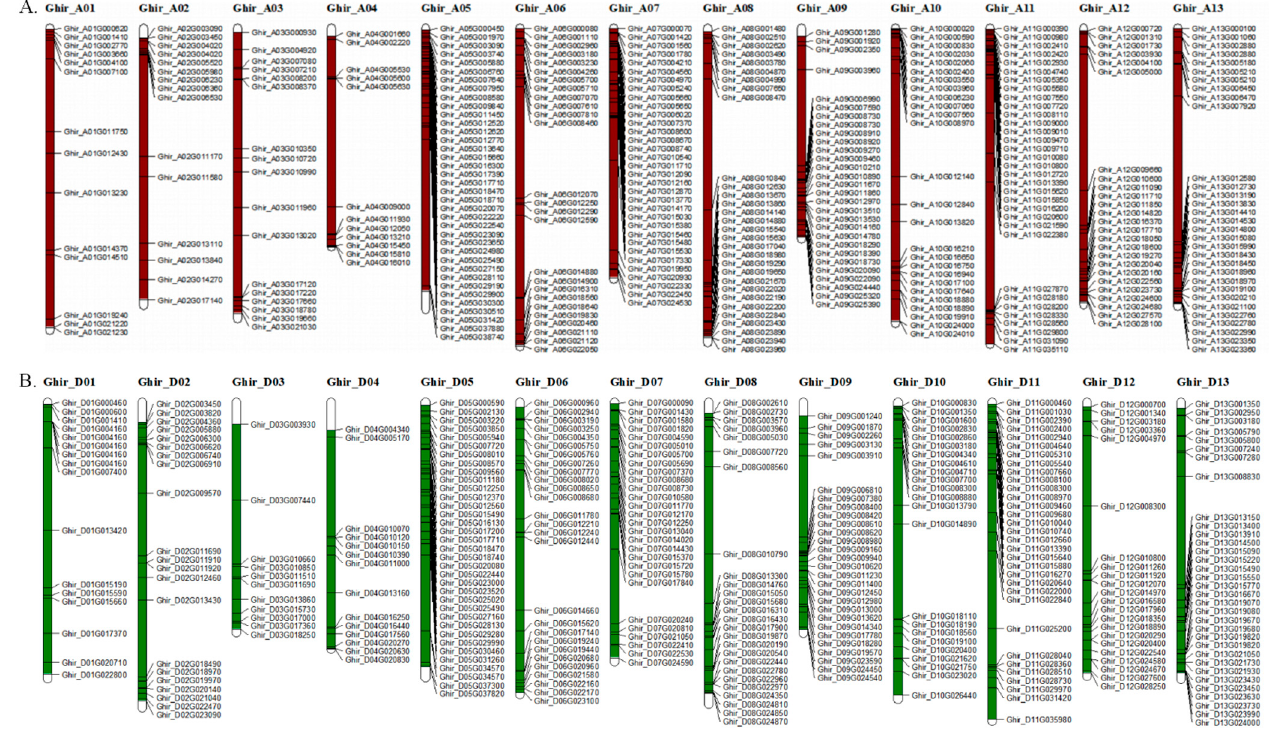
Figure 2. Distribution of flowering-related genes on G. hirsutum chromosomes. ( A ) Brownish bars: pseudochromosomes of the At subgenome; green bars: pseudochromosomes of the Dt subgenome. ( B ) Black lines on brownish and green bars indicate the locations of flowering-related genes on the pseudochromosomes. Values corresponding to the scales on the black vertical line indicate the physical distances.